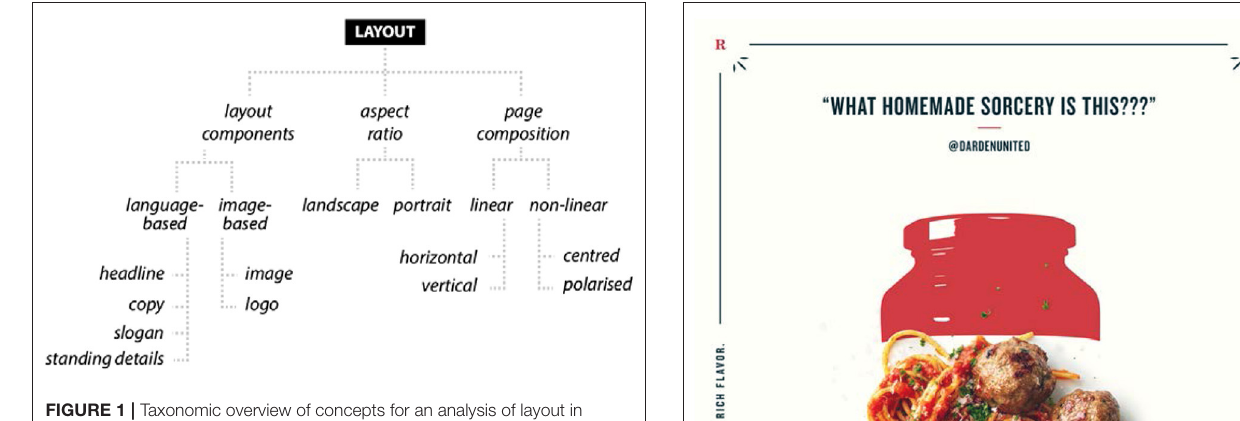
correspond to standard generic stages of the print